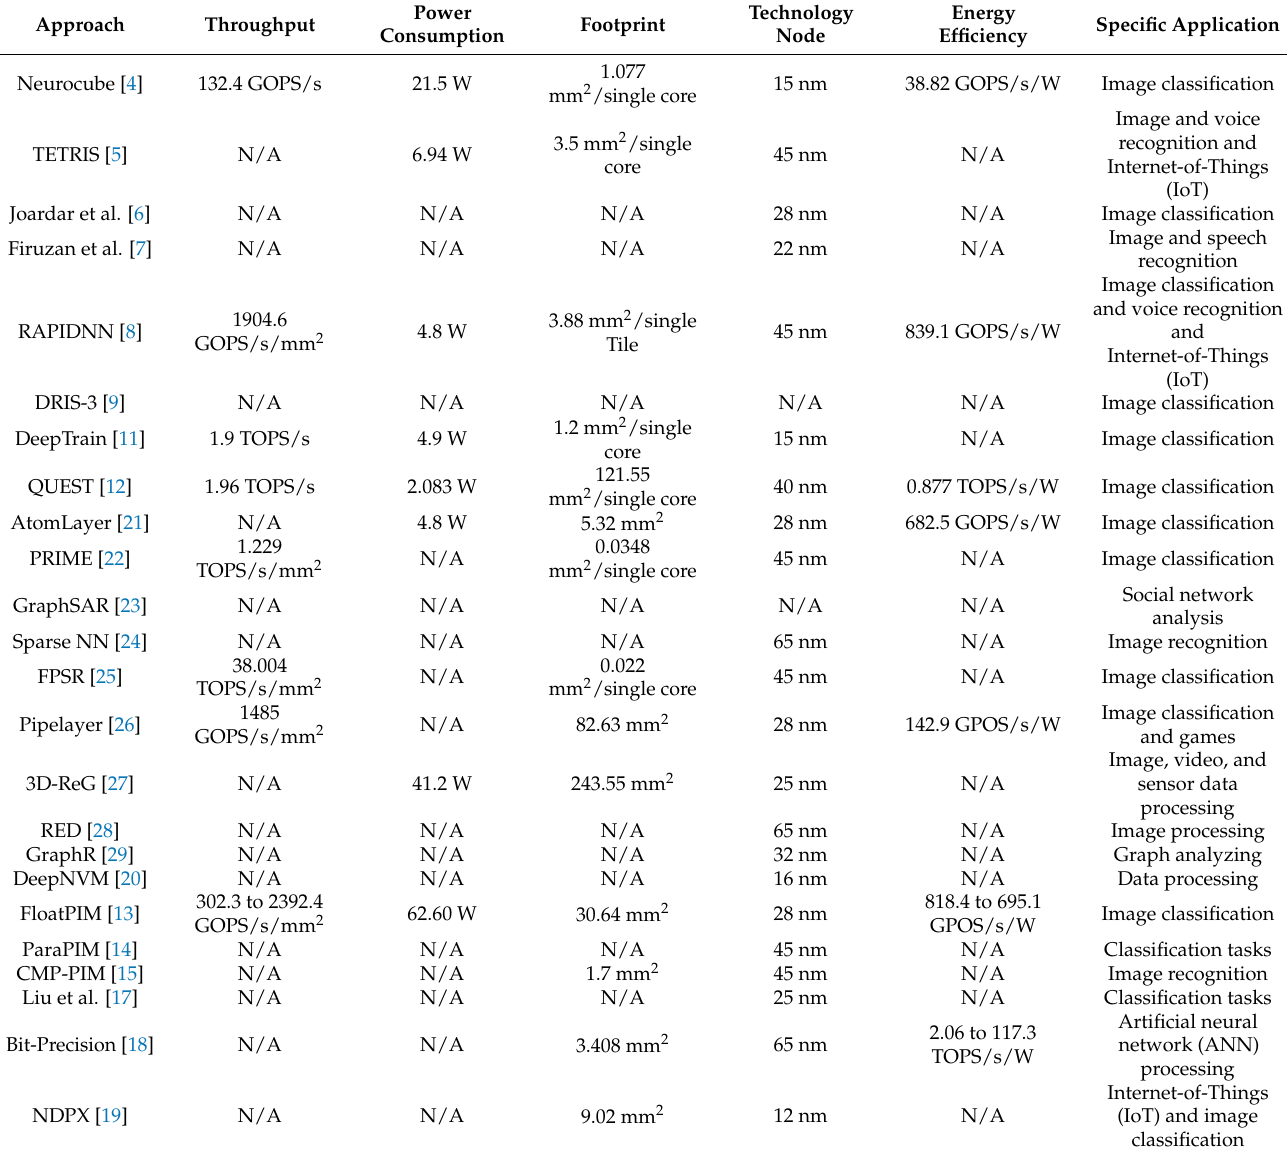
Table 2. Ranking of the reviewed architectures in this